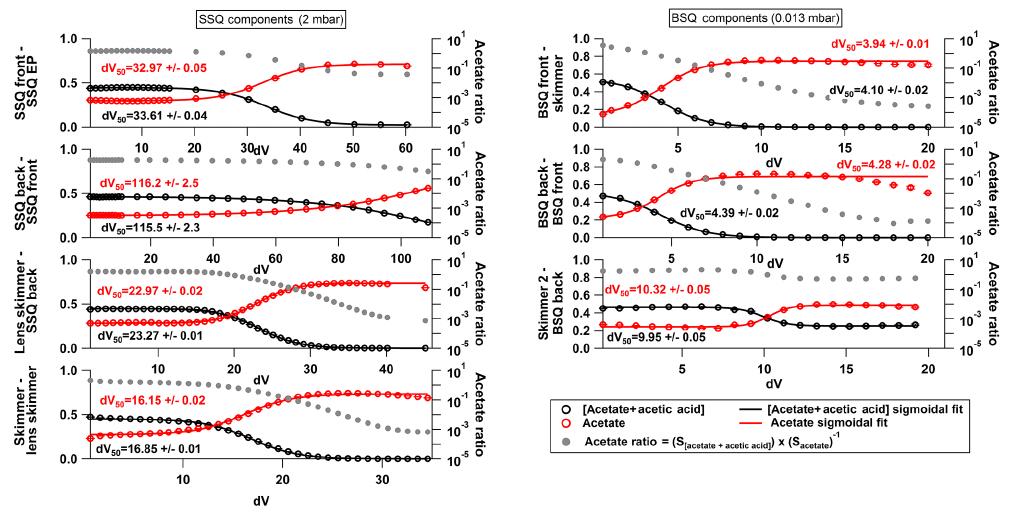
Figure 4. Voltage scan results conducted between the seven component relations in the API. Acetate (red dots) and the [acetic acid + acetate] cluster (black dots) are plotted on the left axis. Fitted dV 50 values for acetate (red trace) and the [acetic acid + acetate] cluster (black trace) are included along with the least-squares sigmoidal fit. The acetate ratio (gray dots) is plotted on the right axis as a log scale. Left column: components housed in the vacuum chamber containing the SSQ (2mbar). Right column: components housed in the vacuum chamber containing the BSQ